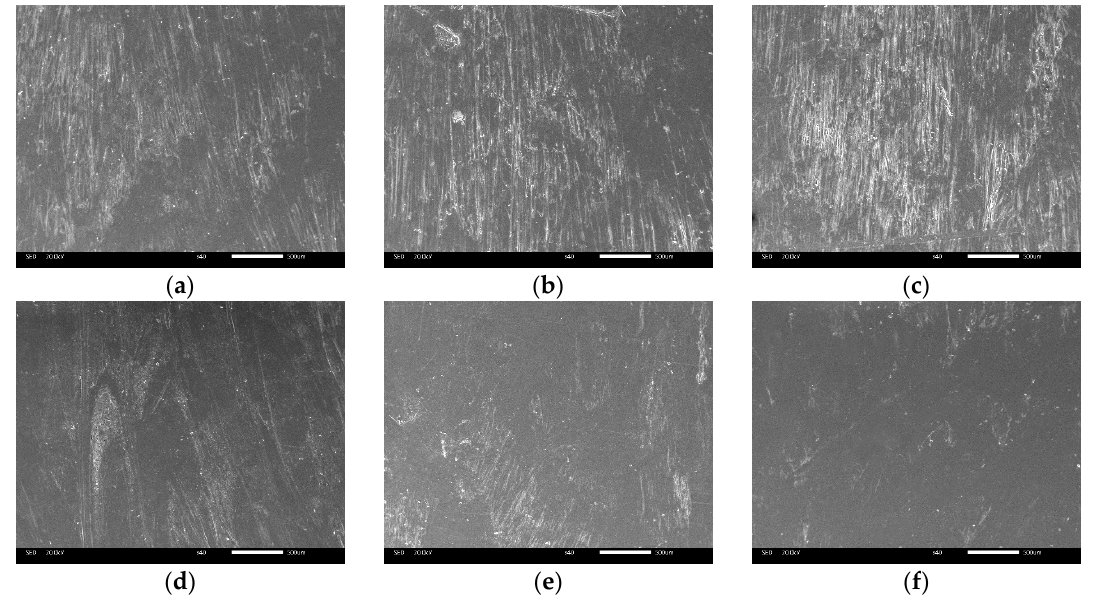
Figure 16. The surface morphology on the film side of foamed composites with different nano-CaCO 3 content: ( a ) 0 wt %; ( b ) 2 wt %; ( c ) 4 wt %; ( d ) 6 wt %; ( e ) 8 wt %; ( f ) 10 wt %.